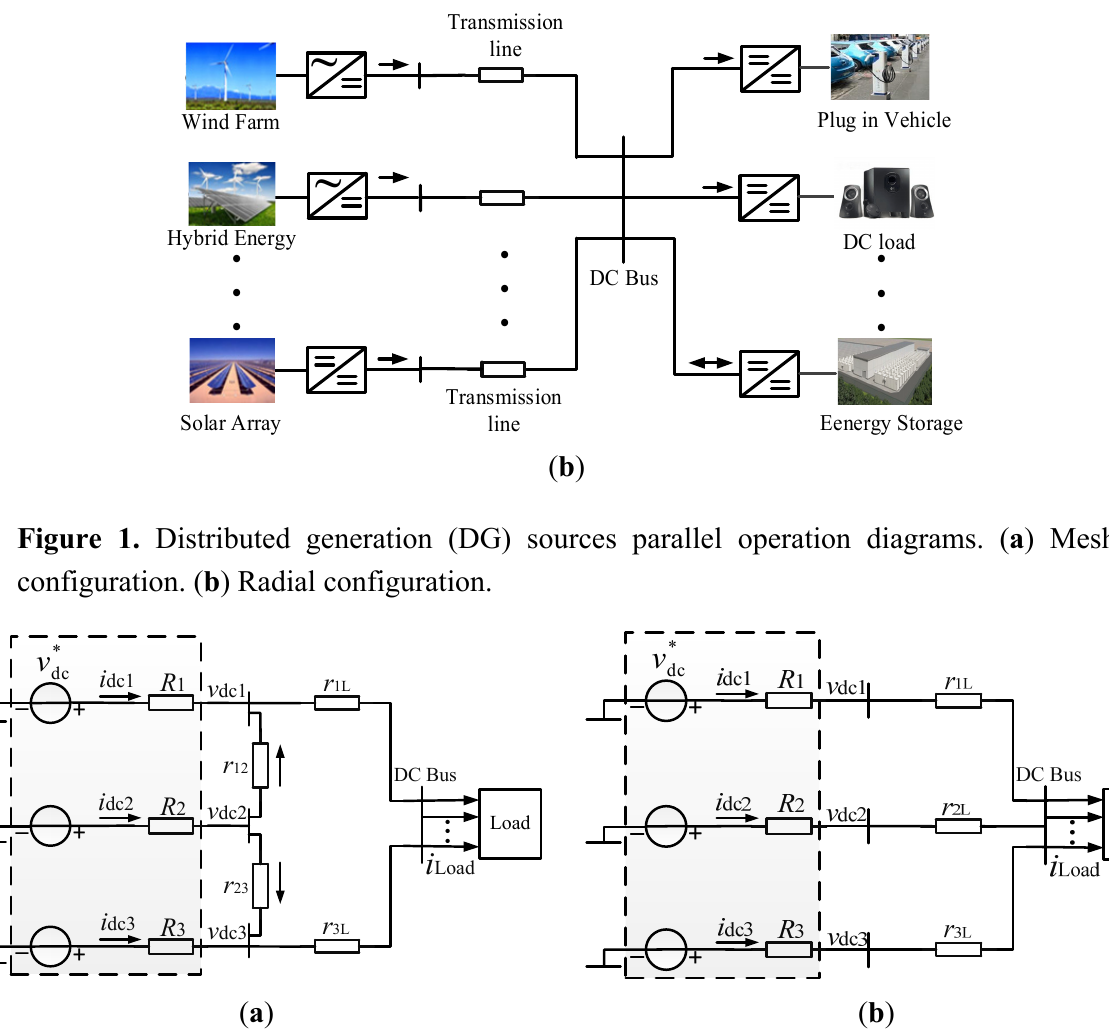
Figure 2. Simplified model of DC microgrid. ( a ) Mesh configuration ( b ) Radial configuration.